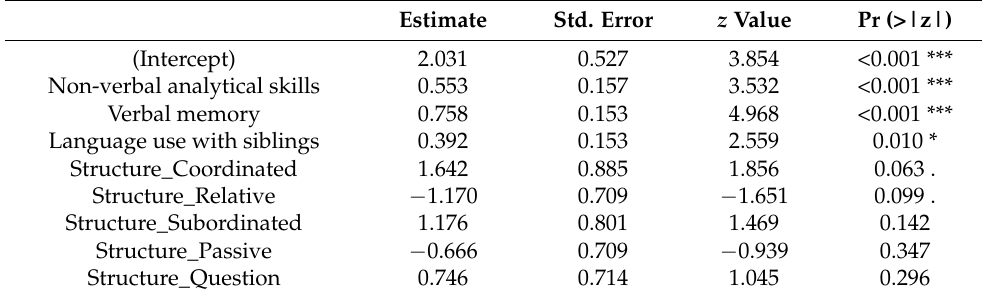
Table A13. English T2 fixed effects.